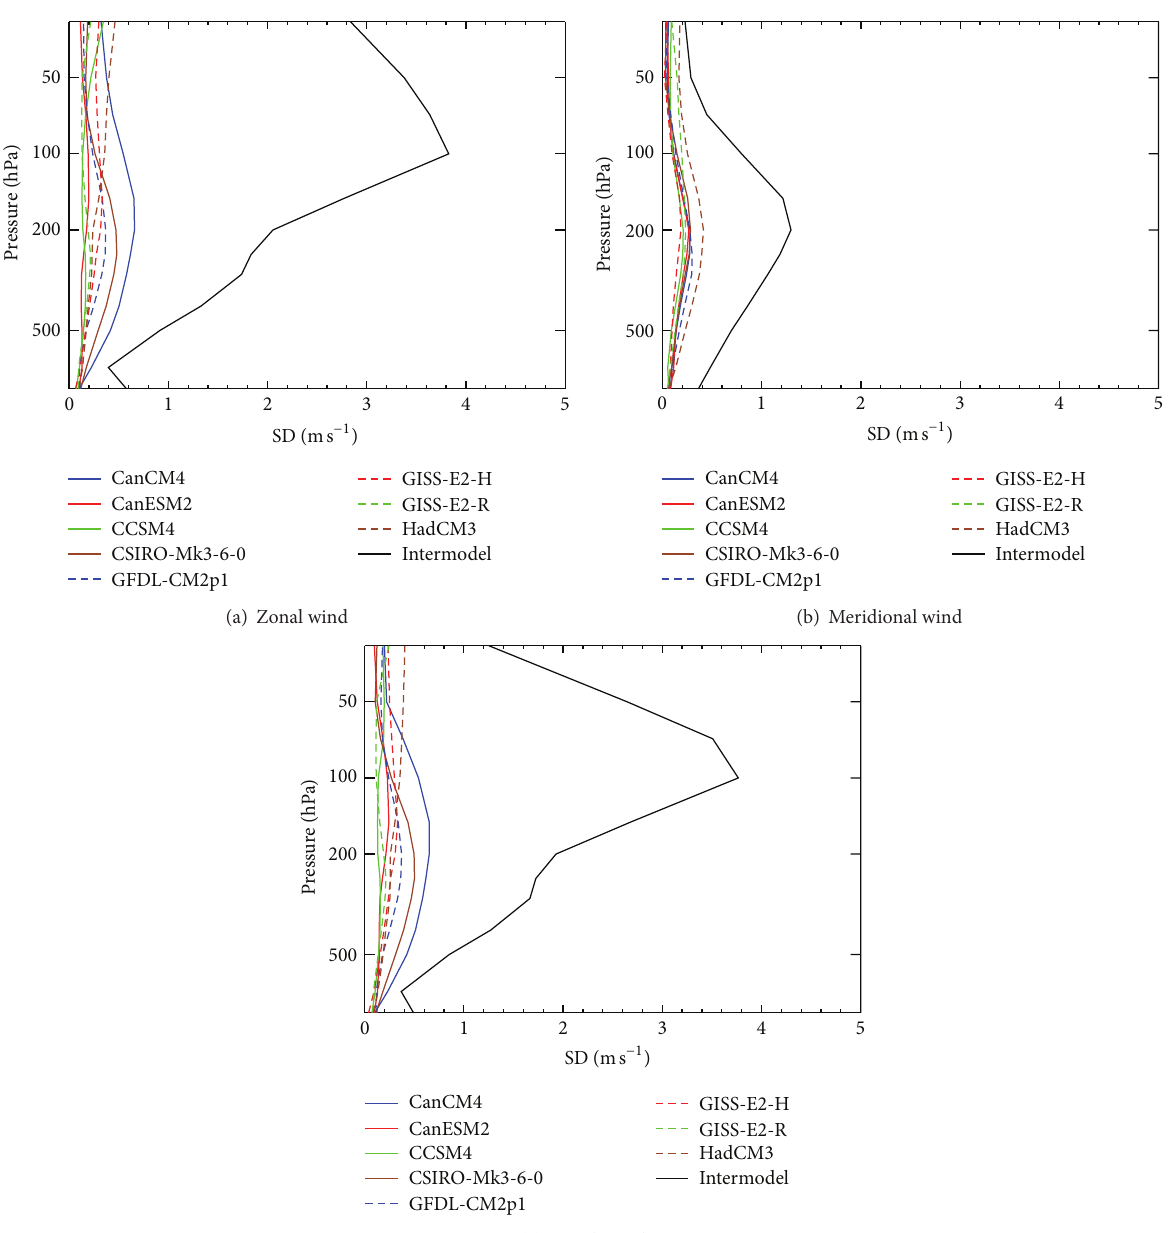
Figure 3: Intramodel and intermodal variability for eight models with at least 5 ensemble